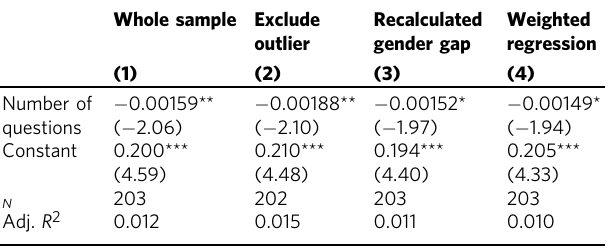
Table 1 Relationship between the gender gap in math and the number of questions Whole sample Exclude Recalculated Weighted outlier gender gap